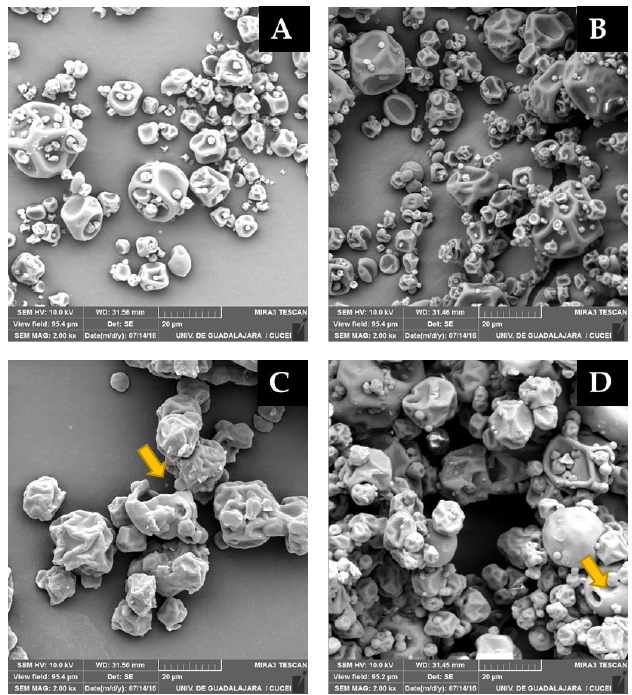
Figure 3. SEM images of spray-dried microcapsules of green coffee oil after 30 days of storage 32% RH. ( A , B ) Mesquite gum microcapsules produced at 185 °C (left) and 200 °C (right), emulsion stabilized by mesquite gum, and ( C , D ) OSA-starch microcapsules produced at 170 °C (left) and 200 °C (right).